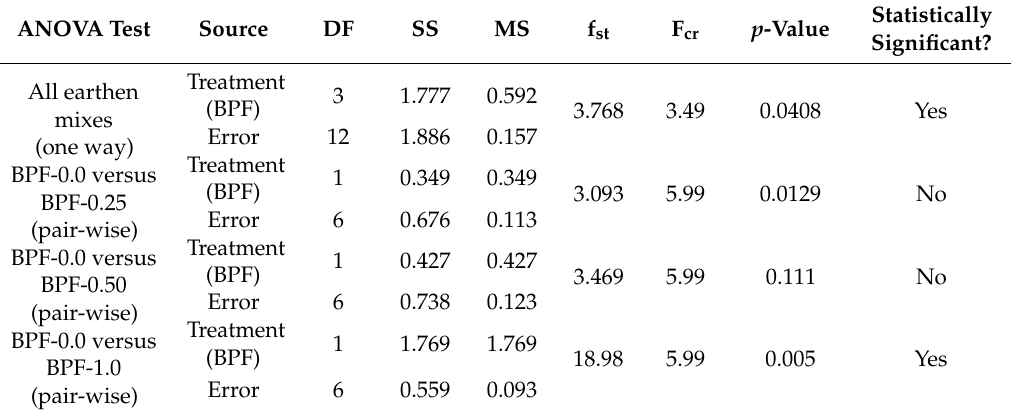
Table 4. 5% significance level ANOVA tests for the capillary water absorption rate ( I ) of earthen mixes at 17.3 s 0.5 (300 s).